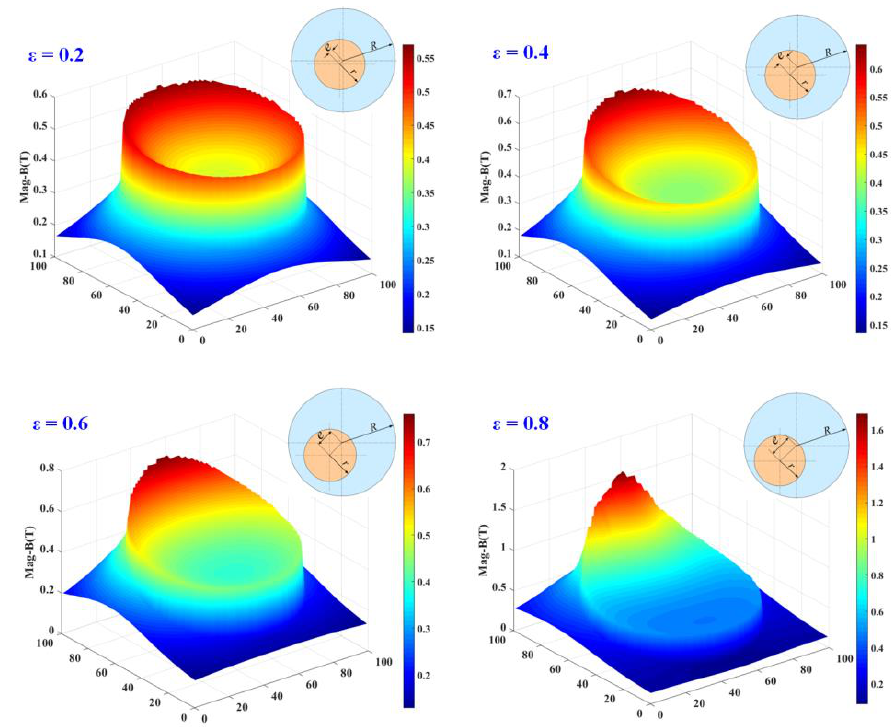
Figure 14. Magnetic field distribution of magnetic fluid lubrication film.